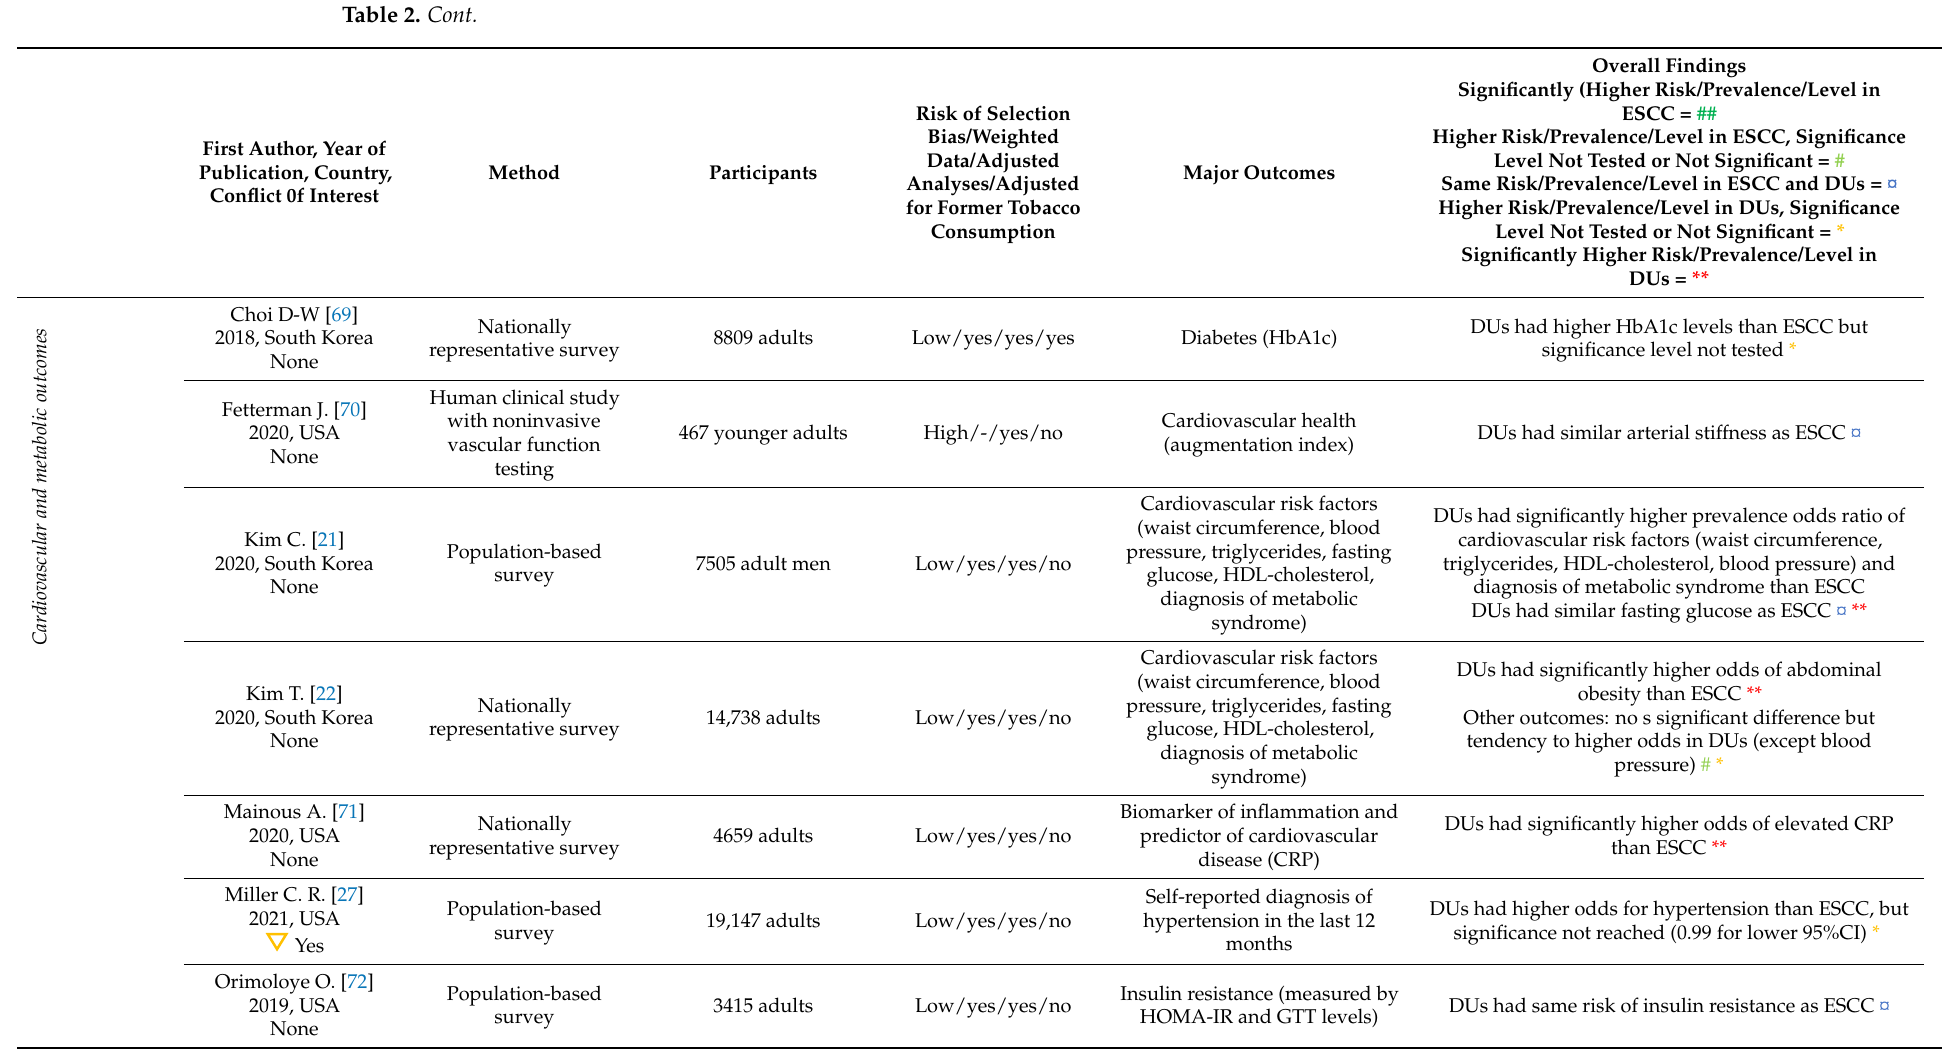
Table 2. Cross -sectional studies investigating potential harm of DUs compared to